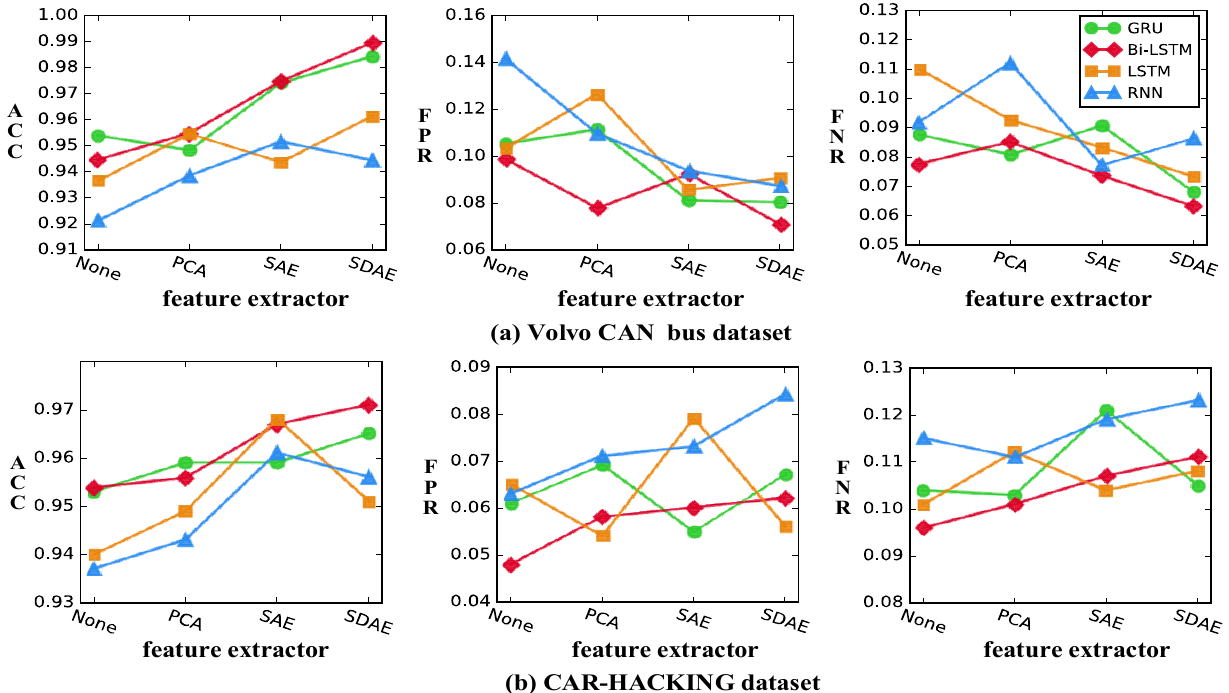
Figure 8. Performance analysis of Bi-LSTM situation predictor. ( a ) the comparison results of the four predictors on Volvo CAN bus dataset; ( b ) the comparison results of the four predictors on CAR-HACKING dataset.